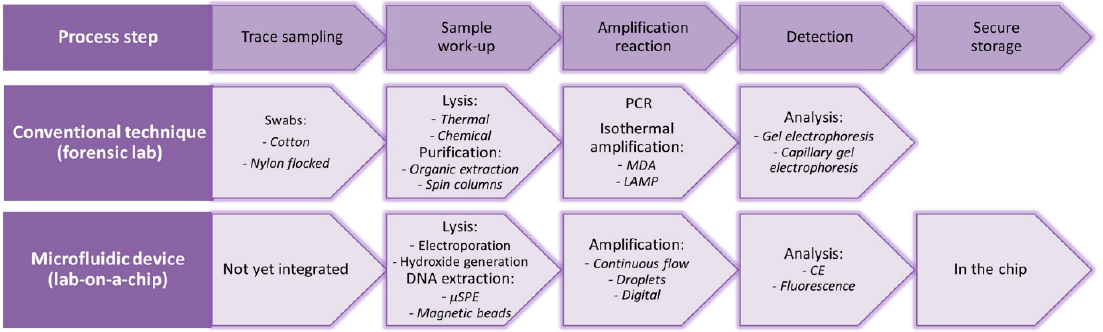
Figure 7. In the top row, the consecutive steps in the process of forensic DNA analysis are listed; within the middle row, the conventional technique with some examples. In the bottom row, microfluidic analogies can be found with some examples. (Reproduced from Ref. [137], an